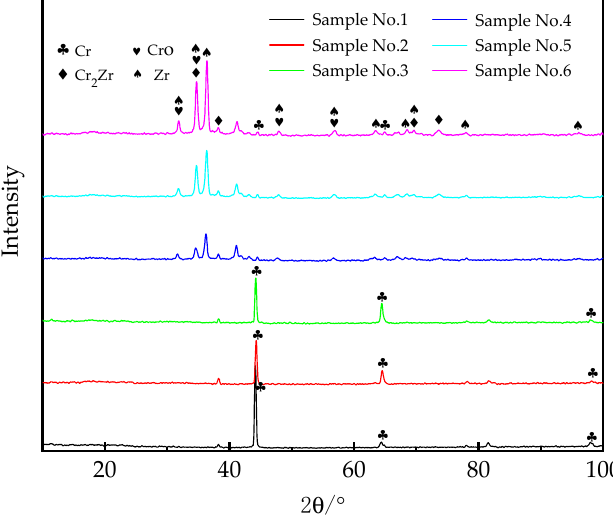
Figure 5. X-ray di ff raction pattern of the Cr coatings on Zr-4 substrates surface at di ff erent laser Figure 5. X-ray diffraction pattern of the Cr coatings on Zr-4 substrates surface at different laser power power densities.